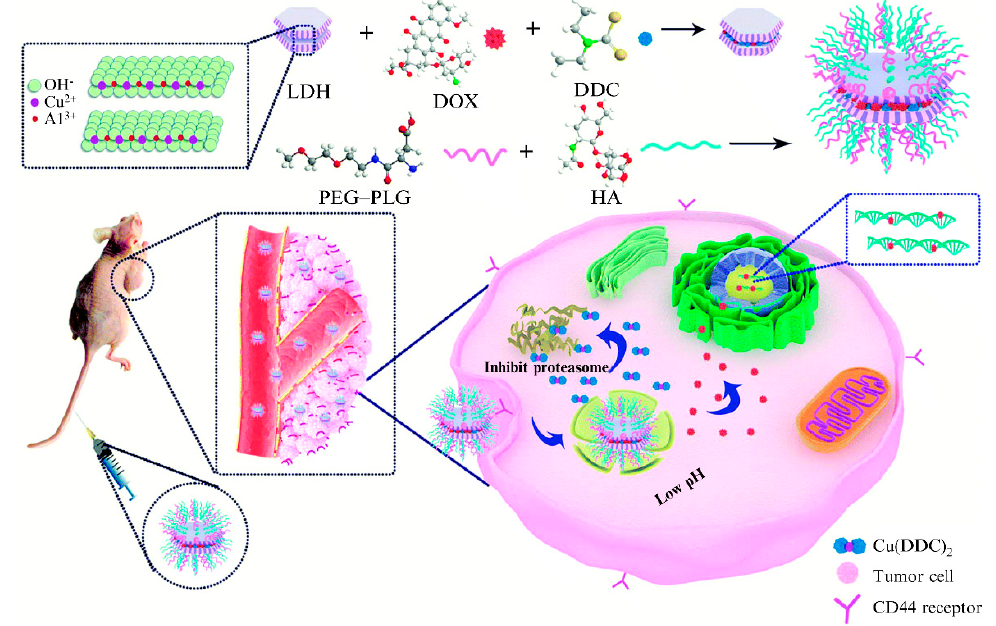
Figure 14. Schematic plot of the preparation, accumulation at the tumor site, and internalization into the cancer cells of hyaluronic acid/polyethylene glycol-graft-polyglutamic acid@LDHs@ diethyl- dithiocarbamate/doxorubicin. Reproduced with permission from